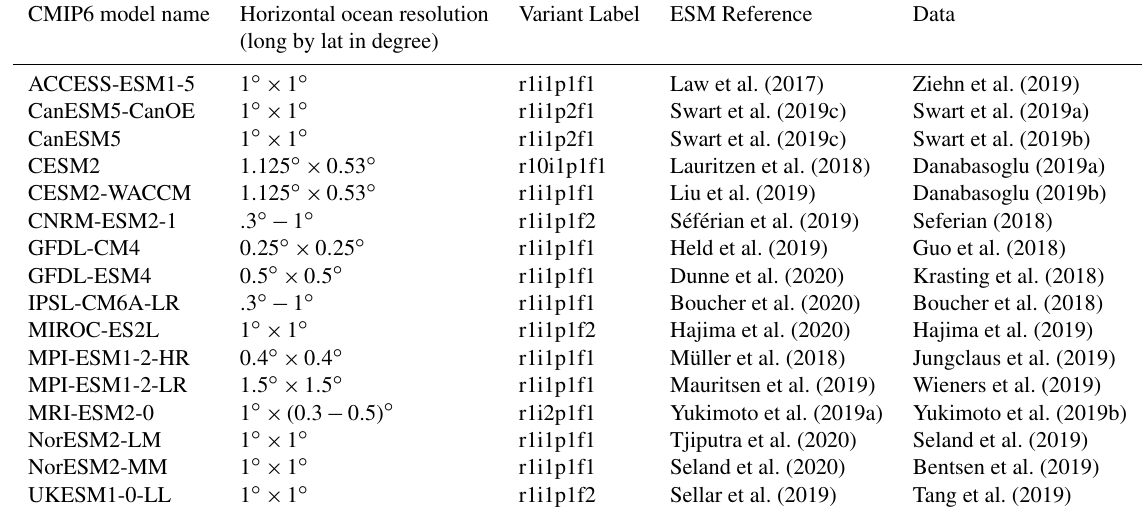
Table 2. List of the 16 CMIP6 models used in this study with the horizontal resolution of the ocean component, variant label, model, and data references all given. Note that most of the models have irregular grids and the resolutions quoted in the table are